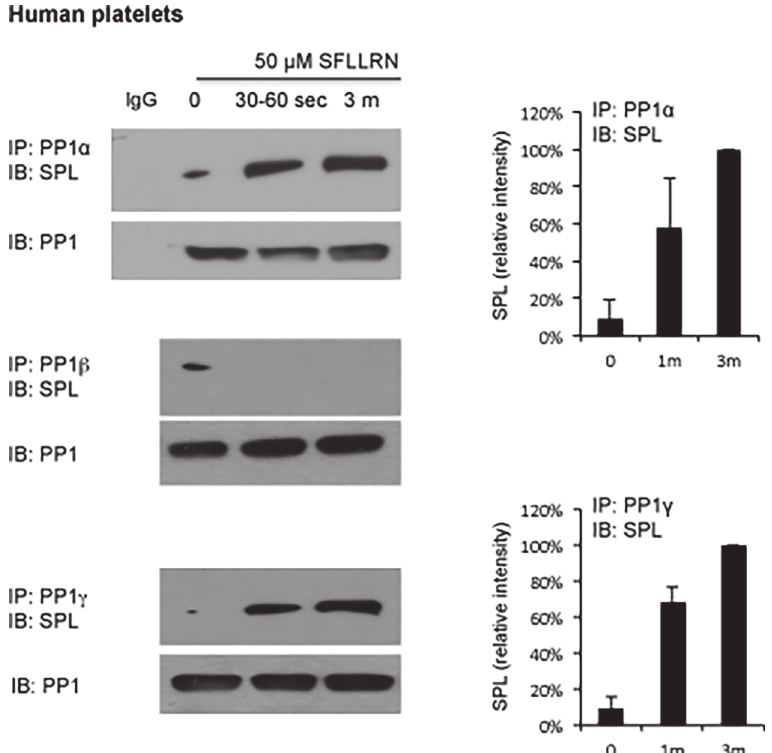
Fig 1. Formation of an SPL/PP1 complex in platelets. Lysates were prepared from platelets stimulated with the PAR1 agonist peptide, SFLLRN, after which PP1 precipitated with isoform-selective antibodies or nonimmune immunoglobulin (Ig) and probed with anti-spinophilin before re-probing with a pan-PP1 (E-9) antibody. The graphs for PP1 α and γ summarize results from two experiments expressed as % of the result obtained at 3 min. No binding of PP1 β was detectable at either time point after the addition of SFLLRN.